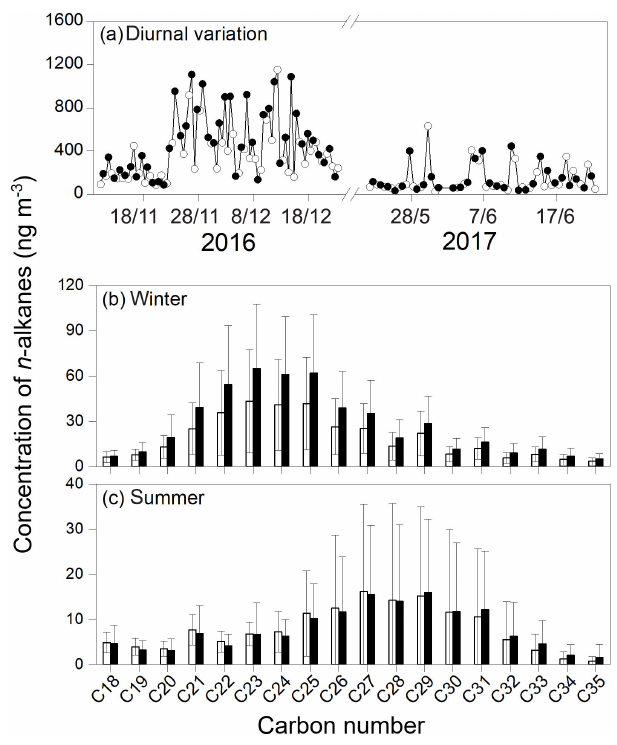
Figure 3. Temporal variations (a) and molecular distributions of n - alkanes during both winter (b) and summer (c) in Tianjin (white and black represent day- and night-time